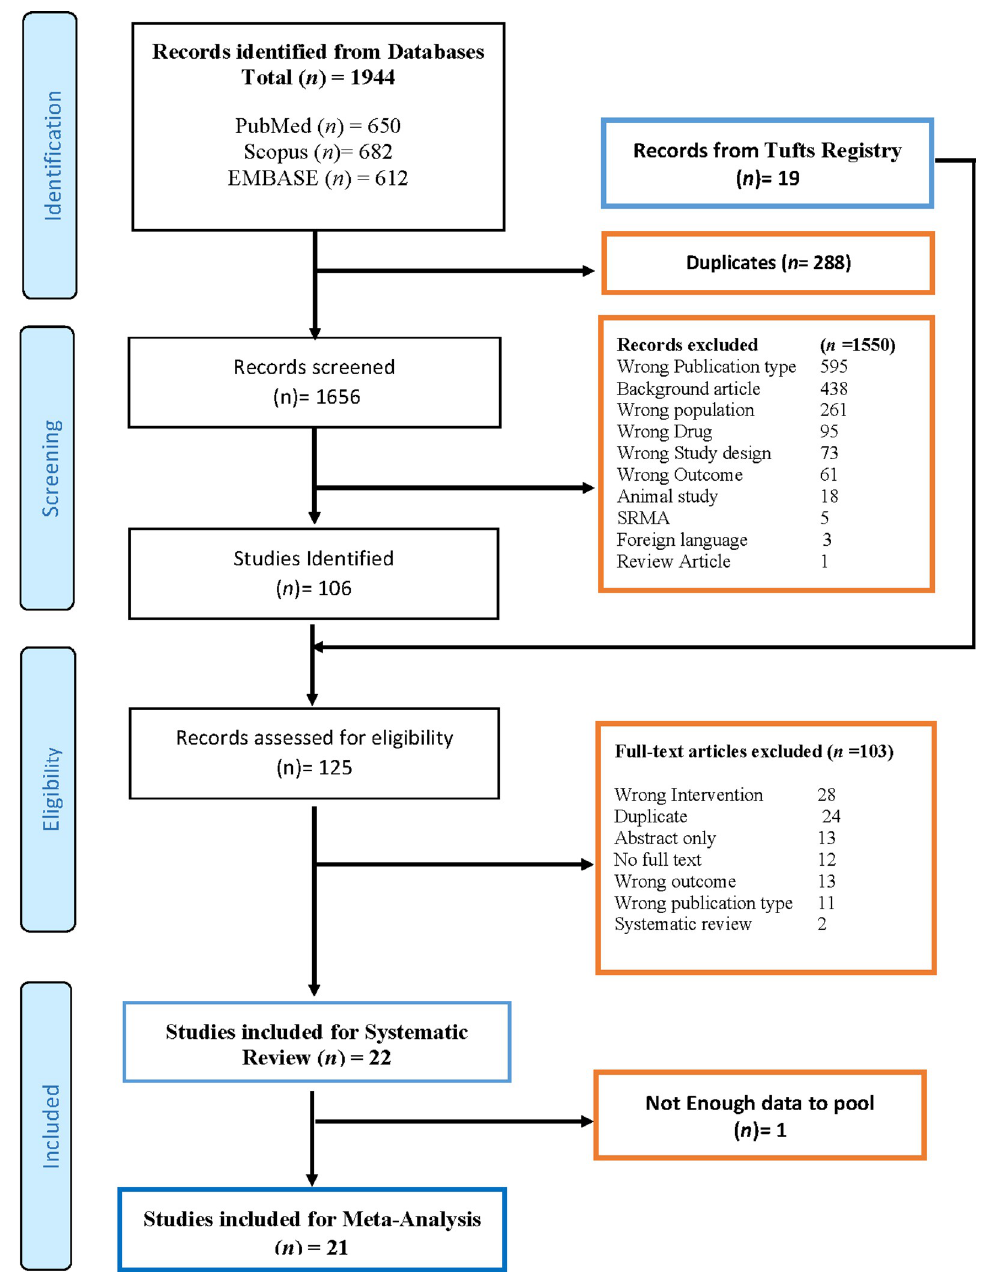
Fig 1. PRISMA flow